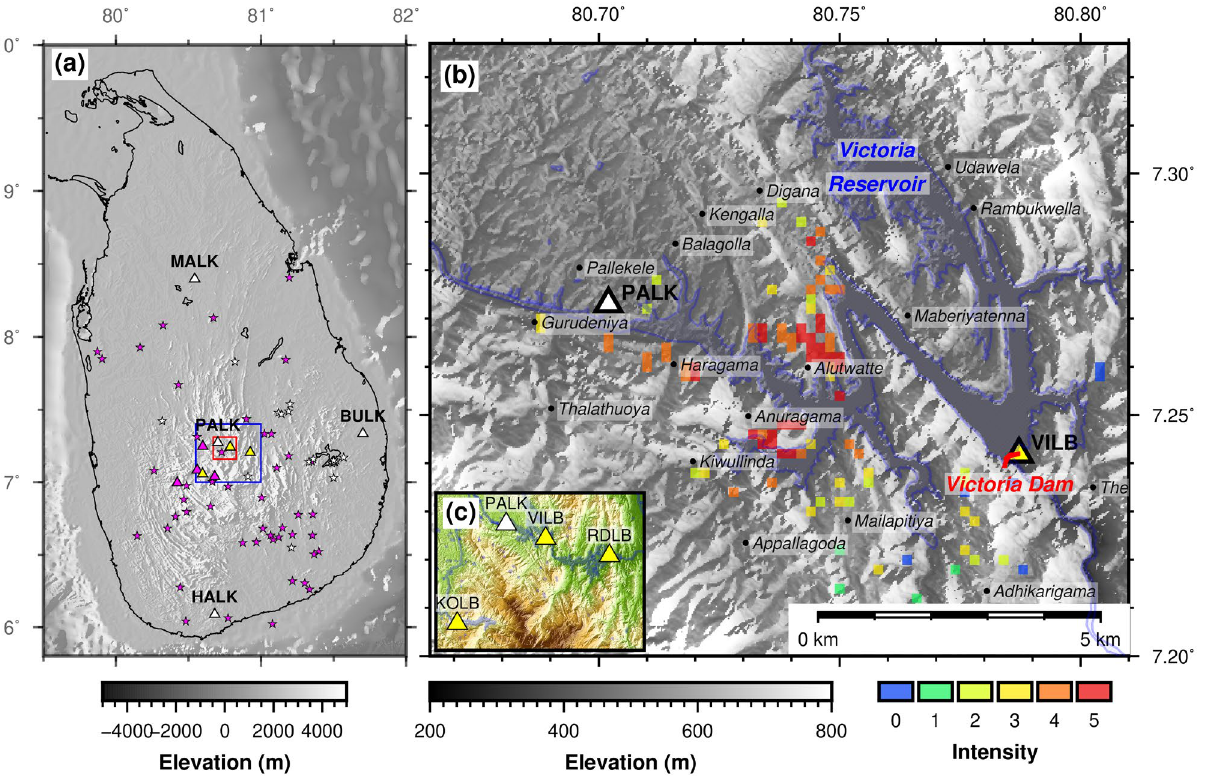
Figure 1. Historical seismicity in Sri Lanka and felt intensity map around the Victoria Reservoir for the 29 August 2020 earthquake. ( a ) Historical seismicity of Sri Lanka. Purple stars are earthquake epicenters from a temporary network (purple triangles) that operated between 1983 and 1984 16 . White stars are earthquake epicenters from the modern seismograph network (white triangles). Red rectangle indicates the extent of ( b ). The blue rectangle indicates the extent of ( c ). ( b ) Felt intensity on an arbitrary categorical scale of the earthquake that occurred on 29 August 2020 in close proximity to the Victoria Reservoir 52 . ( c ) Locations of the